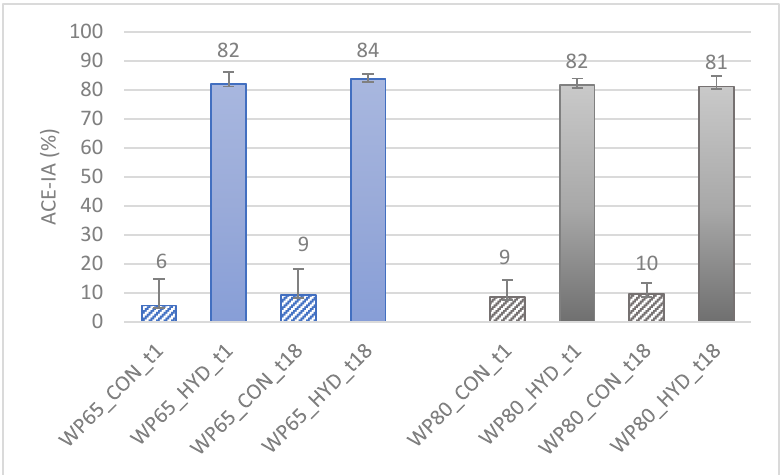
Figure 3. ACE-IA (%) of the tryptic hydrolysates of 5% ( w / w ) solutions of WPC powders of sheep/goat origin manufactured from Feta cheese whey in comparison to non-treated counterparts. Abbreviations explained in Table 1 and Section 2.2.3. Means and standard deviations of three experiments.